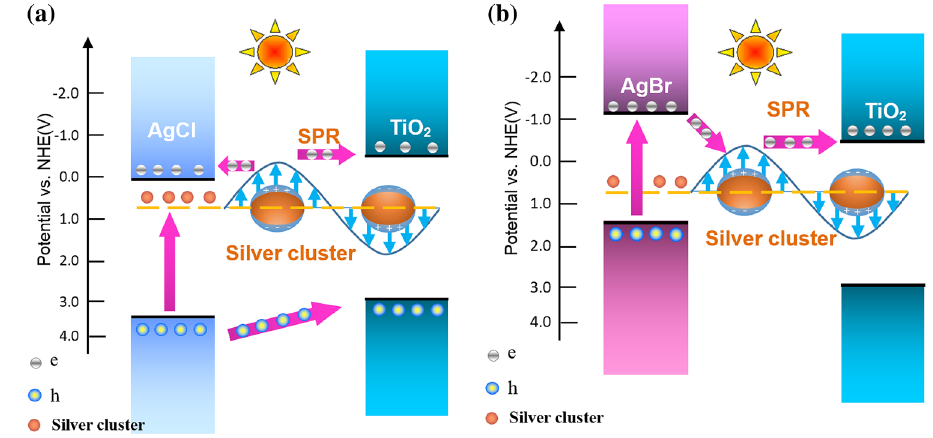
Fig. 8 Band structures and degradation mechanisms of a Ag–AgCl@TiO 2 NPAS and b Ag–AgBr@TiO 2 NPAS under visible